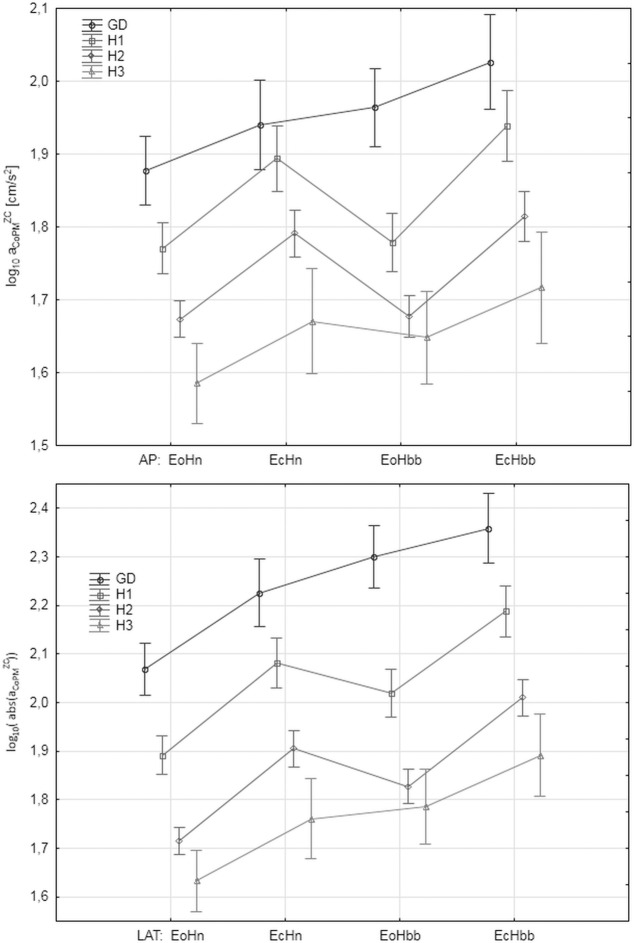
The mean values of LACoPM = mean(log10(aCoPMZC)) in the subsequent patients and registration condition groups.aCoPMZC
represents the acceleration of the xCoPM
signal in the given Zero-Crossings point. Upper: antero-posterior (AP), bottom: lateral (LAT) component of the signal. Markers denote the standard error of the mean.